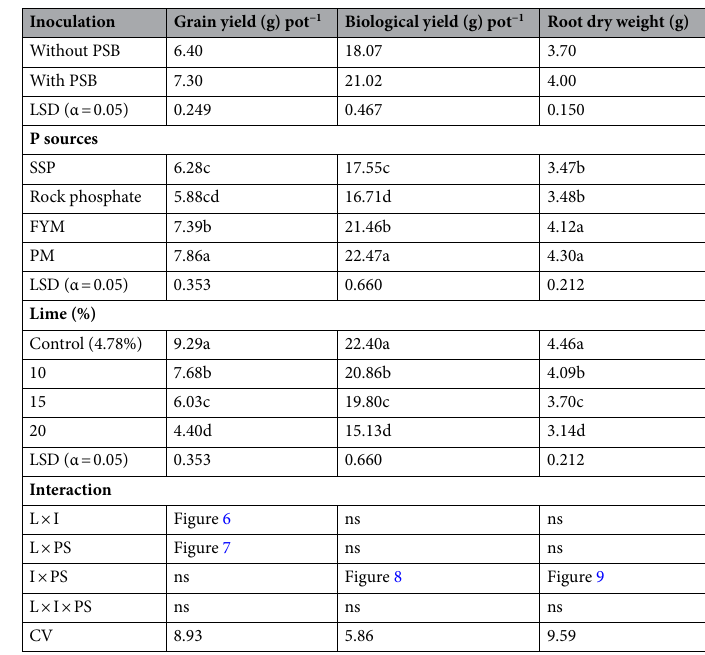
Table 4. Wheat root dry weight, harvest index, grain, biological and straw yield as influenced by PSB inoculation, soil calcification and phosphorus application from different sources. PSB, LSD, SSP, FYM, PM and ns denote phosphate solubilizing bacteria, least significant difference, single super phosphate, farmyard manure, poultry manure and non-significant interaction, respectively. Means with different letter in each column are significantly different at p ≤